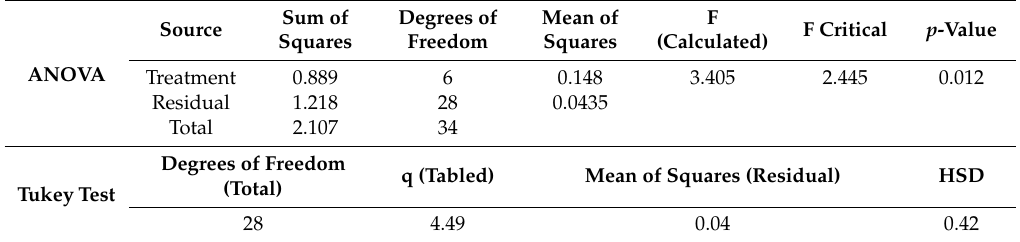
Table 3. Analysis of variance (ANOVA) and Tukey results of Young’s moduli of neat polyester and ra ffi a composites.